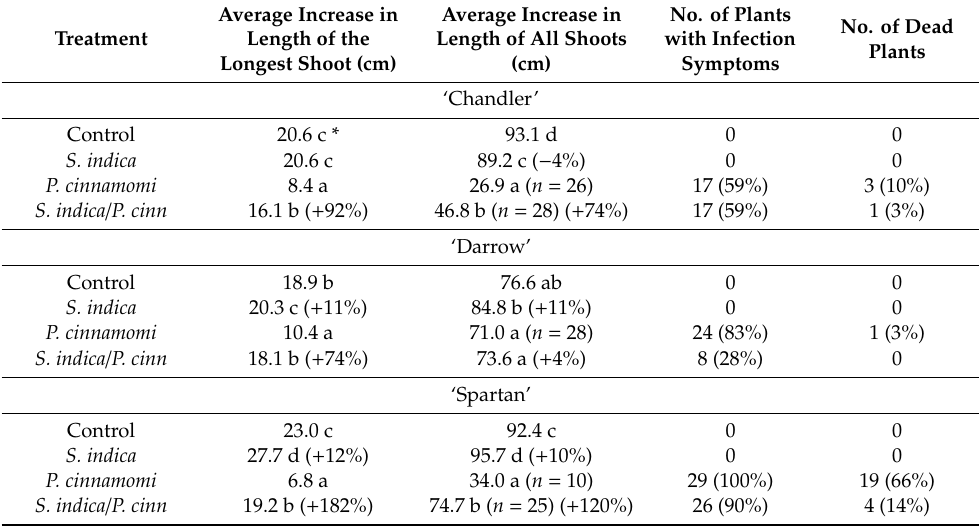
Table 2. Influence of inoculation with S. indica and P. cinnamomi , n = 29, on growth of highbush blueberry and the course of disease as evaluated after 24